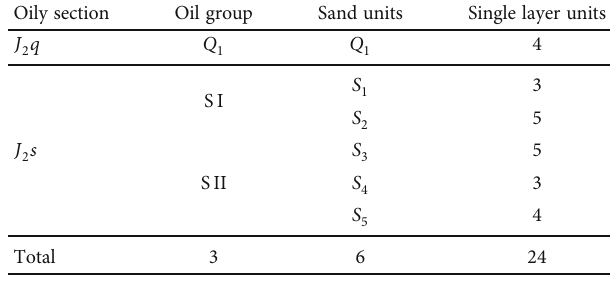
Figure 3: Fault combination and fault system interpretation. Table 1: Sand layer division of Ss reservoir.